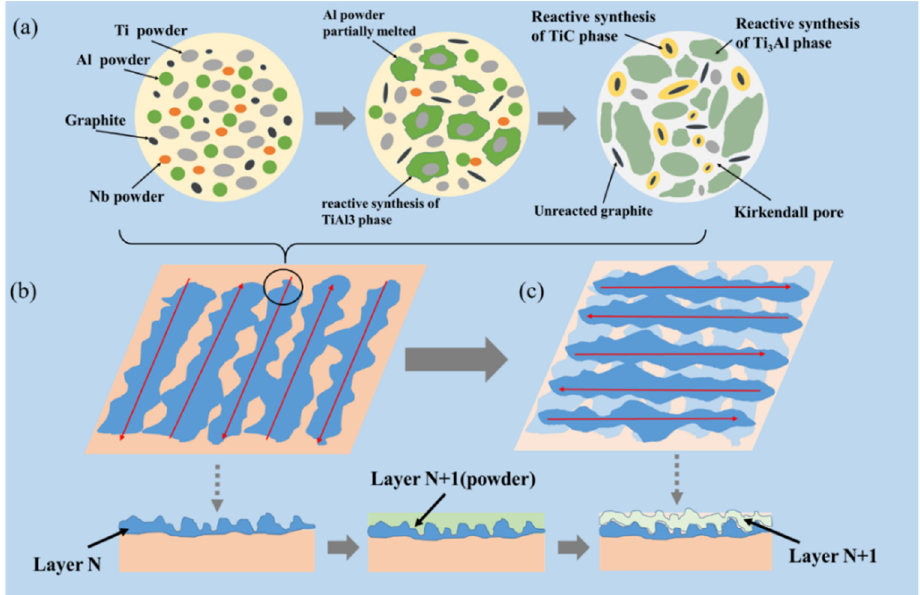
Figure 13. Schematic of the porous structure formation of ISLF sample. ( a ) ISLF reaction process; ( b ) Melt channel of layer N; ( c ) Melt channel of layer N+1.